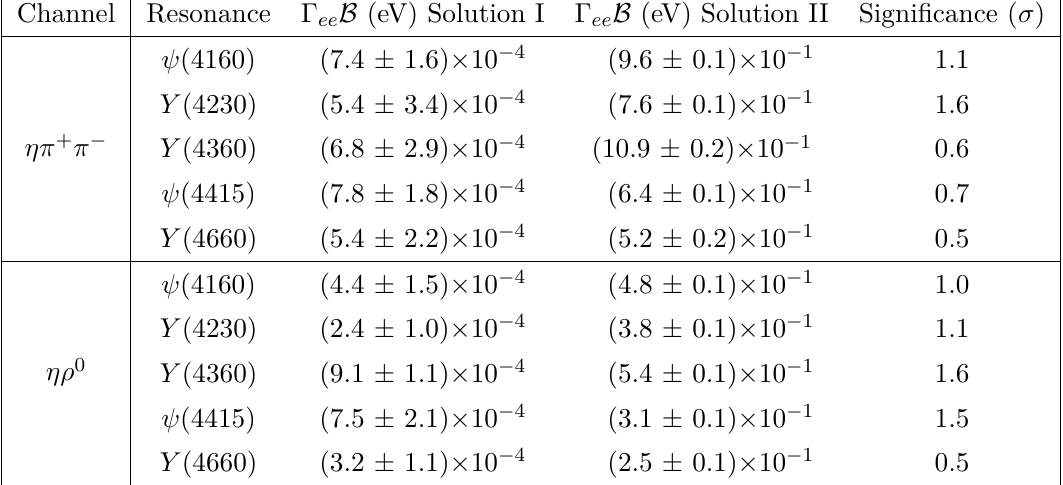
Table 6 . Results of the fits to the Born cross section. Solution I represents the constructive solution, and Solution II represents the destructive